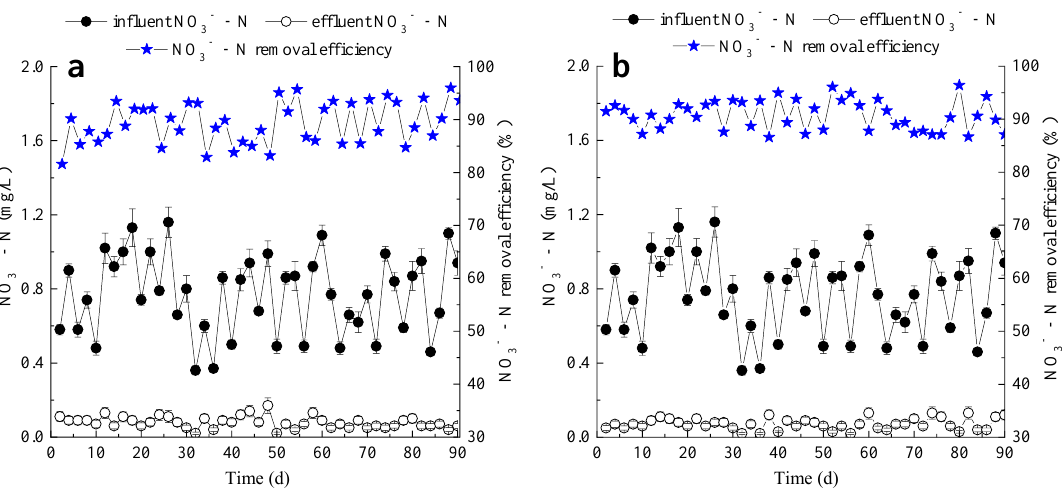
Figure 5. NO 3− −N removal performances in the VFCW ( a ) and HFCW ( b ) ecosystems under different influent loads. The results were the averages and their standard deviations.